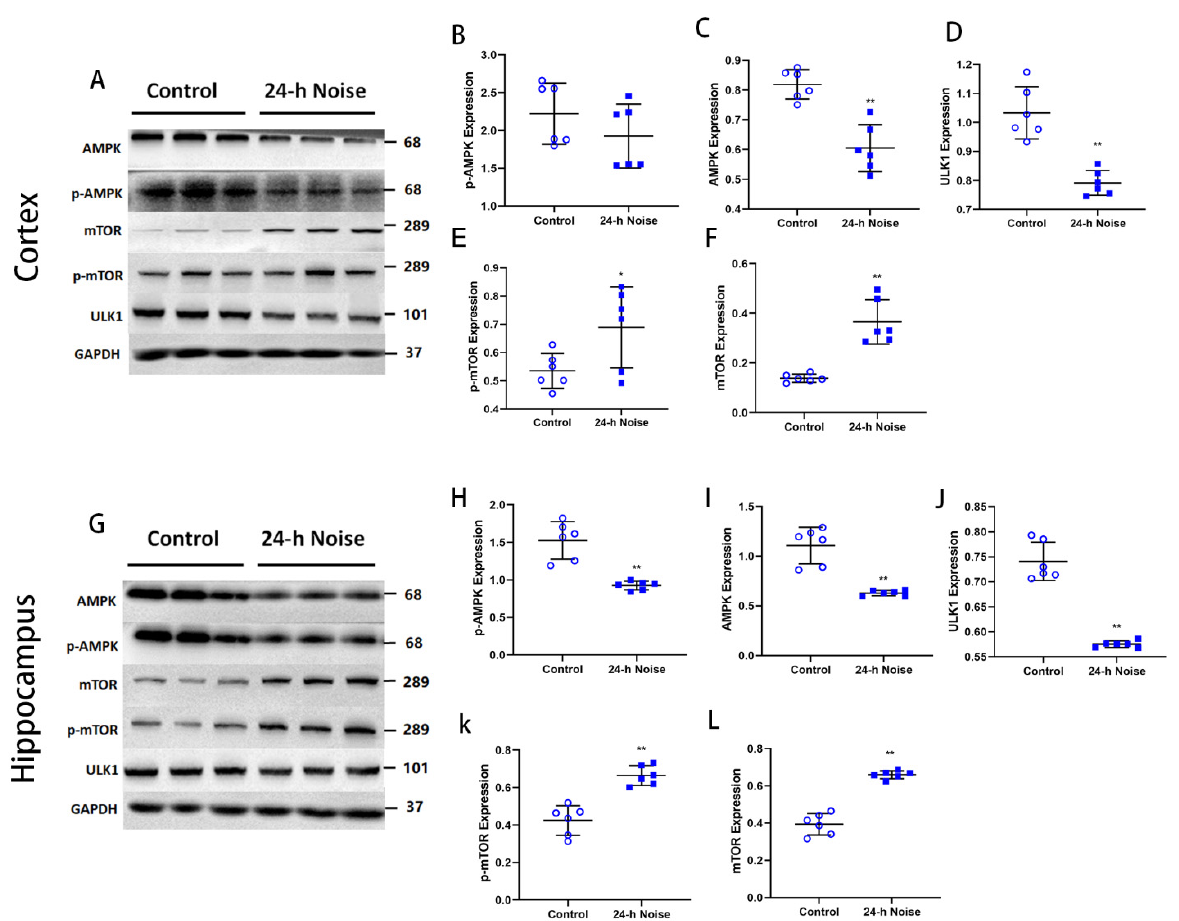
Figure 3. Around-the-clock noise (24 h/day) exposure suppresses the initial stage of autophagy driven by the AMPK-mTOR pathway. ( A , G ) Western blot of AMPK, p-AMPK, mTOR, p-mTOR, and ULK1 expression in the cortex and hippocampus. ( B – F , H – L ) Quantification data showed that around-the-clock noise (24 h/day) affects the expression of AMPK, p-AMPK, mTOR, p-mTOR, and ULK1 in the cortex and hippocampus ( n = 6 per group). * p < 0.05, ** p < 0.01.